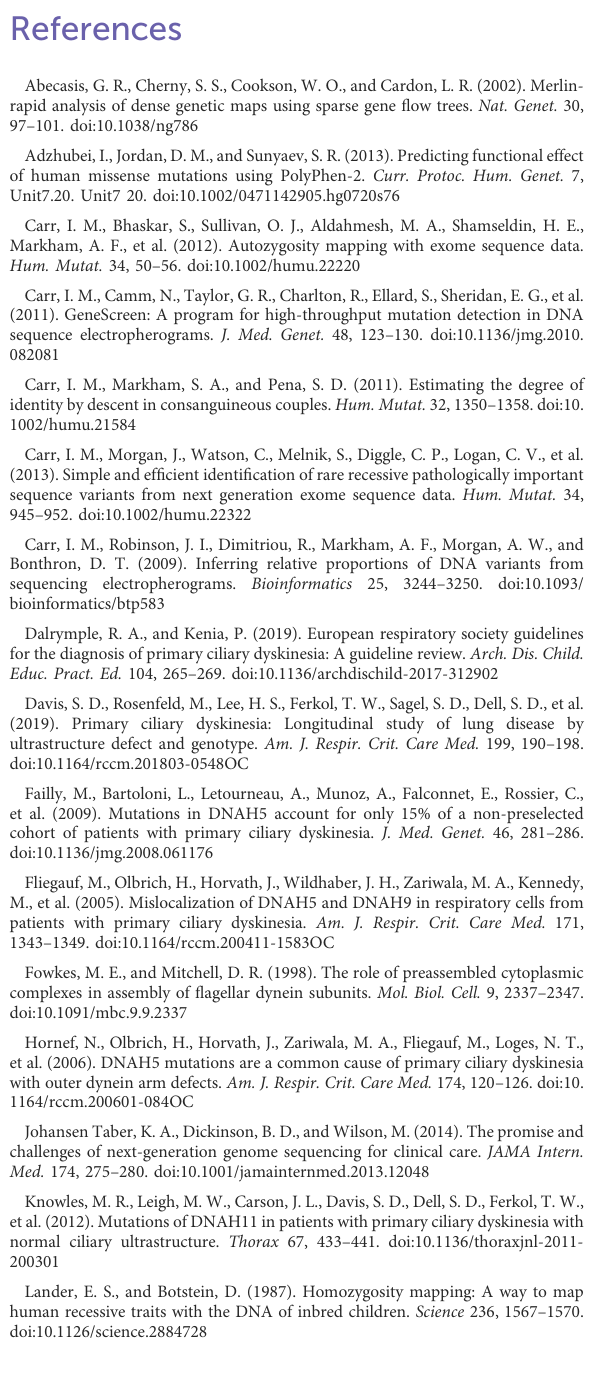
SUPPLEMENTARY FIGURE S3 Allelic discrimination Plot for DNAI2 Mutation. The six patients showed homozygous mutant type pattern (AA; red dots) while their parents showed heterozygous mutant and normal alleles pattern (GA; green dots) consistent with Sanger sequencing data. A control DNA panel composed of 100 DNA samples collected randomly from healthy Arab individuals from different areas in Kuwait were run in the assay and the results showed all the control samples carry the wild type allele in homozygous pattern (GG; blue dots). This indicates that this mutation is very rare and even the carriers are not existing in